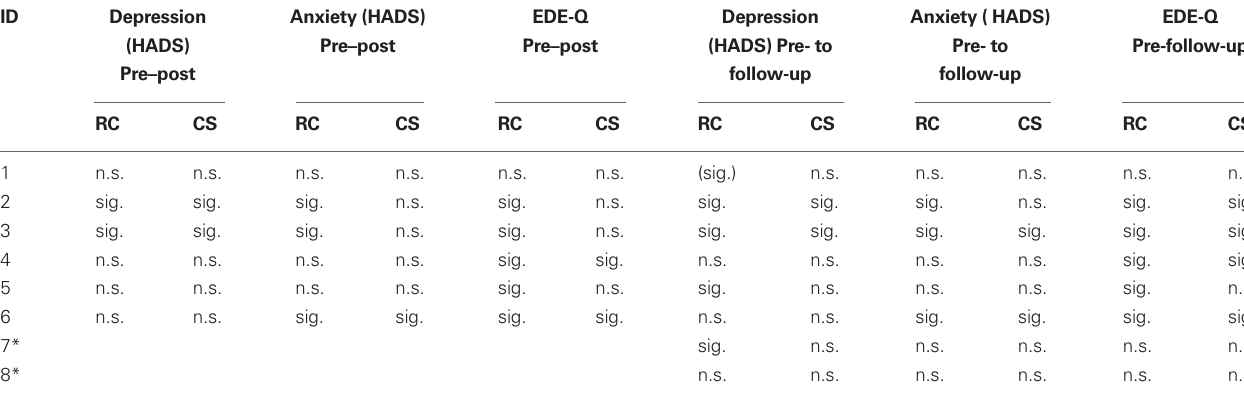
Table 4 | reliable change (rC) and clinical significance (CS) pre-to-post and pre-to-follow-up for treatment completers.